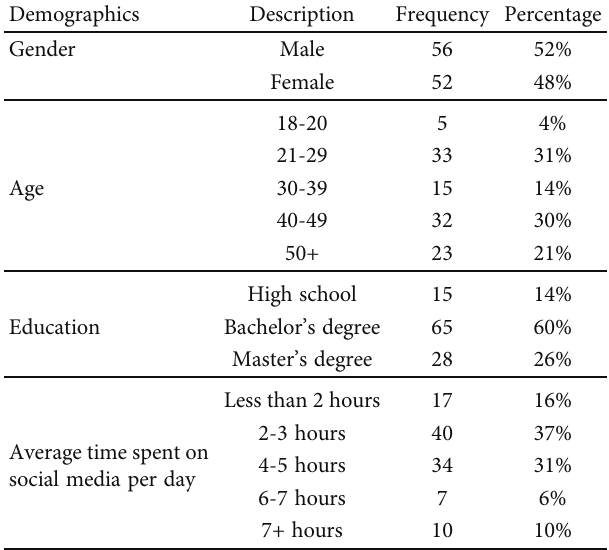
Table 2: Descriptive statistics of demographic result.